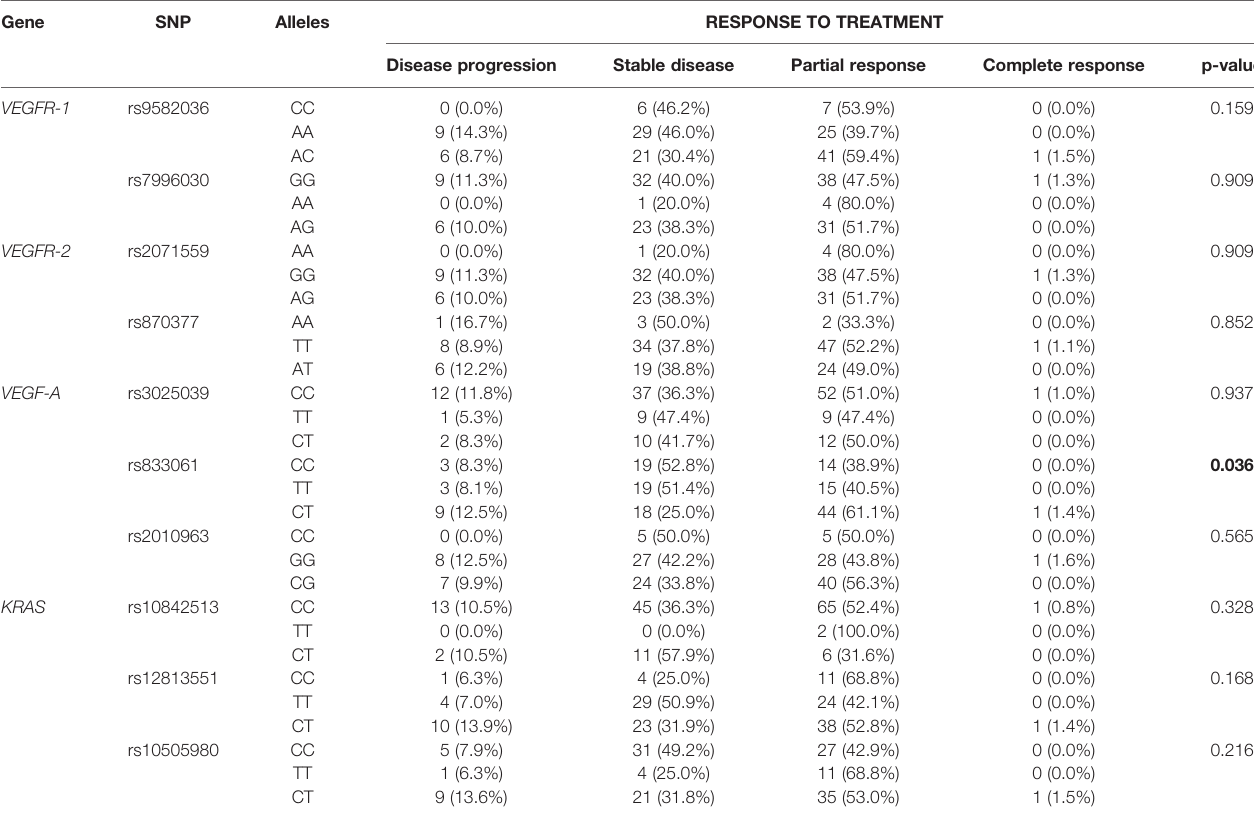
P-values marked with bold indicate statistically signi fi cant